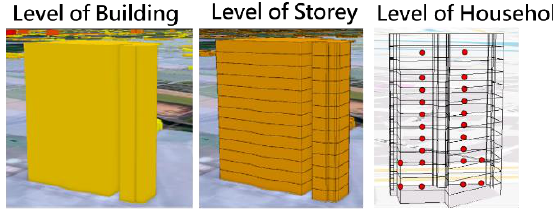
Figure 1. Building, storey, and household of hierarchy representation